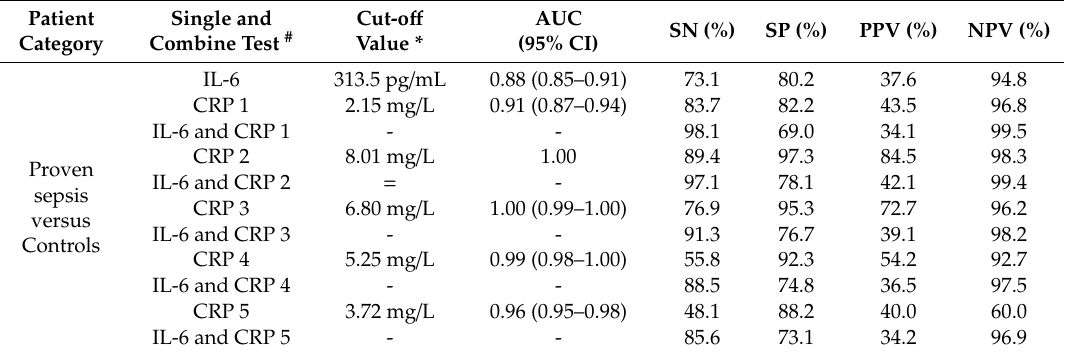
Table 3. Optimum cut-o ff values and diagnostic sensitivity (SN), specificity (SP), positive predictive